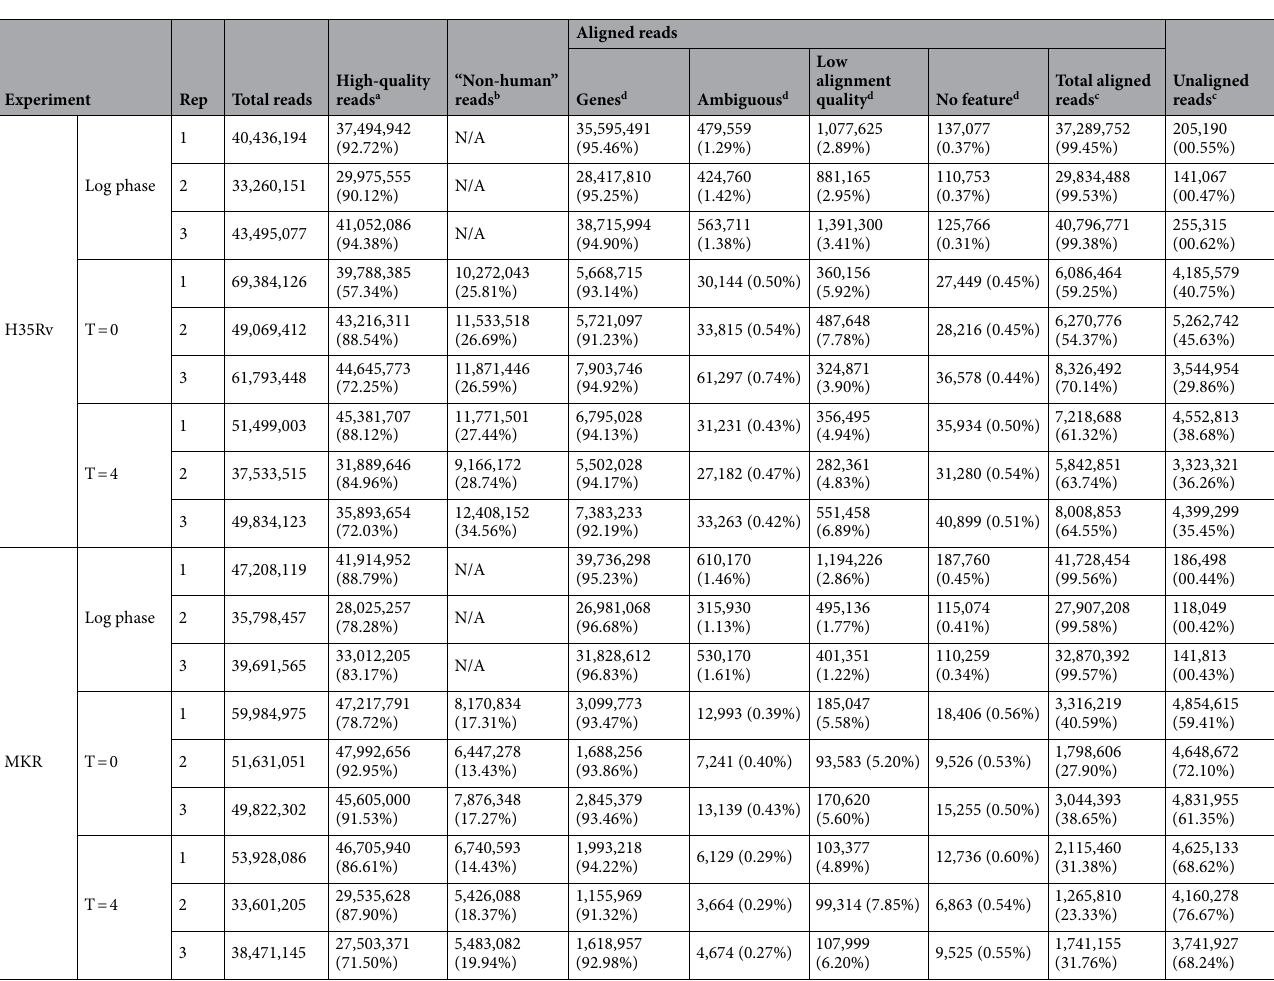
Table 1. RNA-Seq analysis statistics. a The percentages are with respect to the total read numbers. b With respect to the high-quality reads. c With respect to the “non-human” reads. d With respect to the total aligned